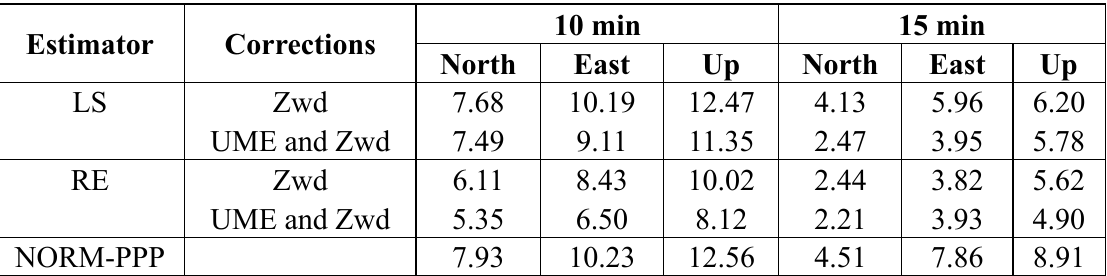
Table 2. RMS (in cm) of different strategies static PPP coordinates with respect to the known coordinates in the North, East and Up